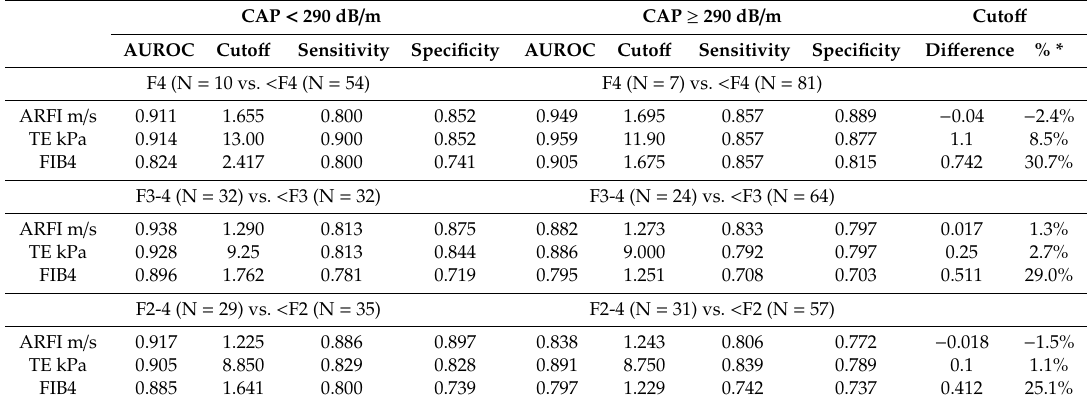
Table 4. E ff ect of hepatic steatosis on cuto ff values of liver fibrosis scores in NAFLD and CHC patients. CAP < 290 dB / m CAP ≥ 290 dB / m Cuto ff AUROC Cuto ff Sensitivity Specificity AUROC Cuto ff Sensitivity Specificity Di ff erence % * F4 (N = 10 vs. < F4 (N = 54) F4 (N = 7) vs. < F4 (N = 81)